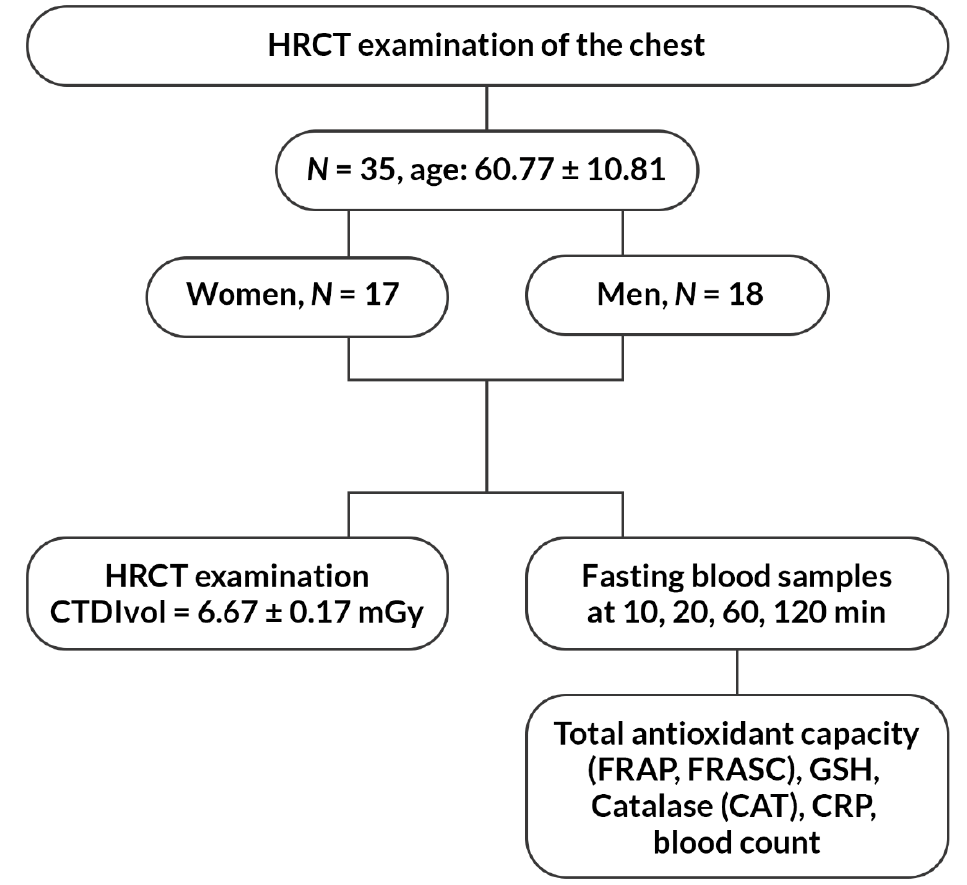
Figure 1. The flow chart of the study.